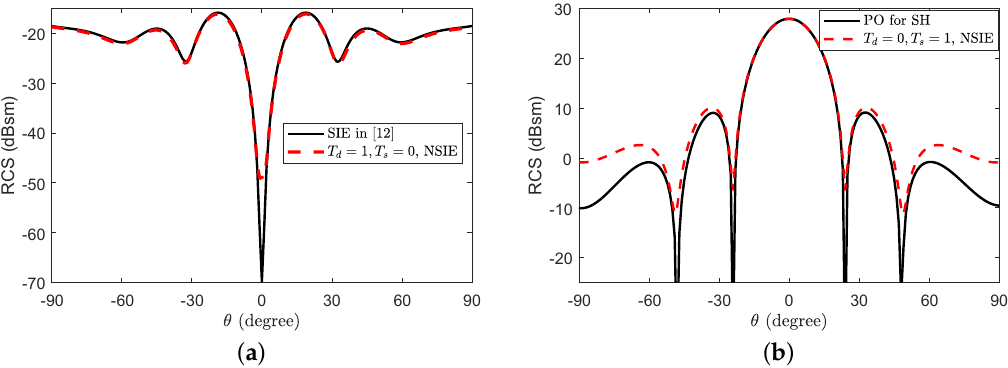
Figure 2. Bistatic radar cross sections (RCS) for the SHDB disk shown in Figure 1 at the frequency of 300 MHz with the incident direction u i = − z . ( a ) T d = 1, T s = 0 (DB surface). ( b ) T d = 0, T s = 1 (SH